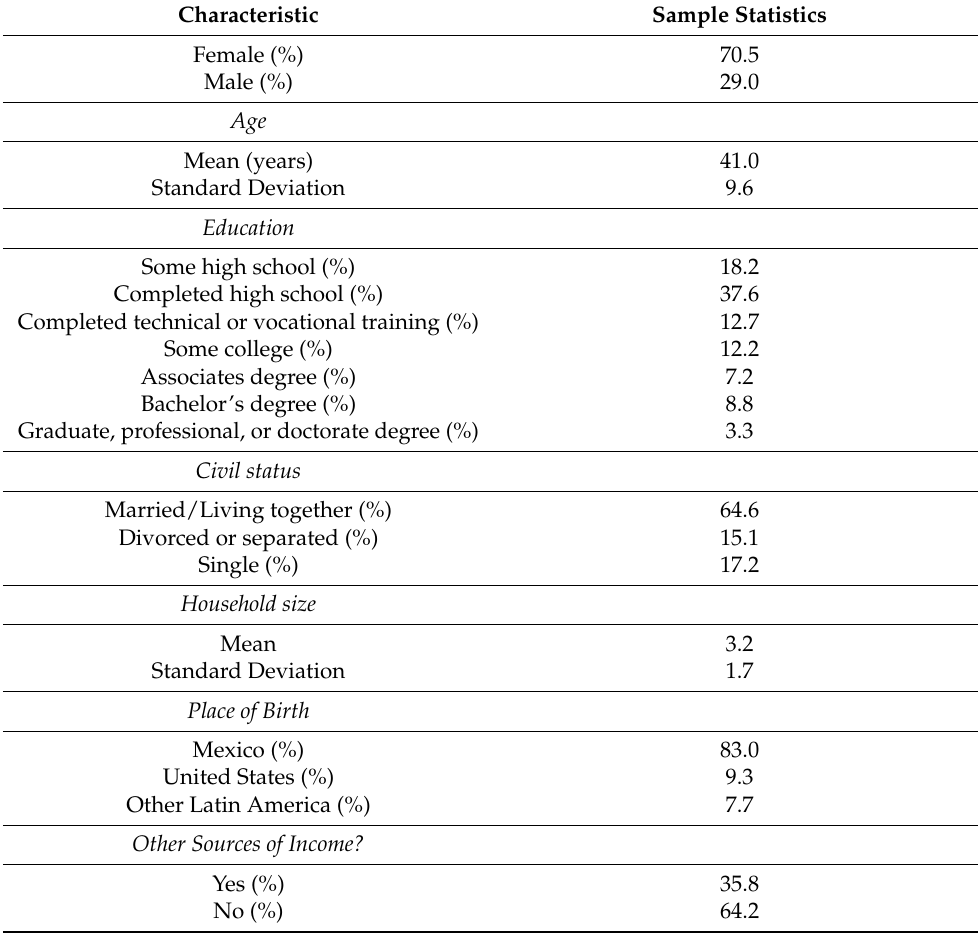
Table 1. Descriptive Statistics for the Survey